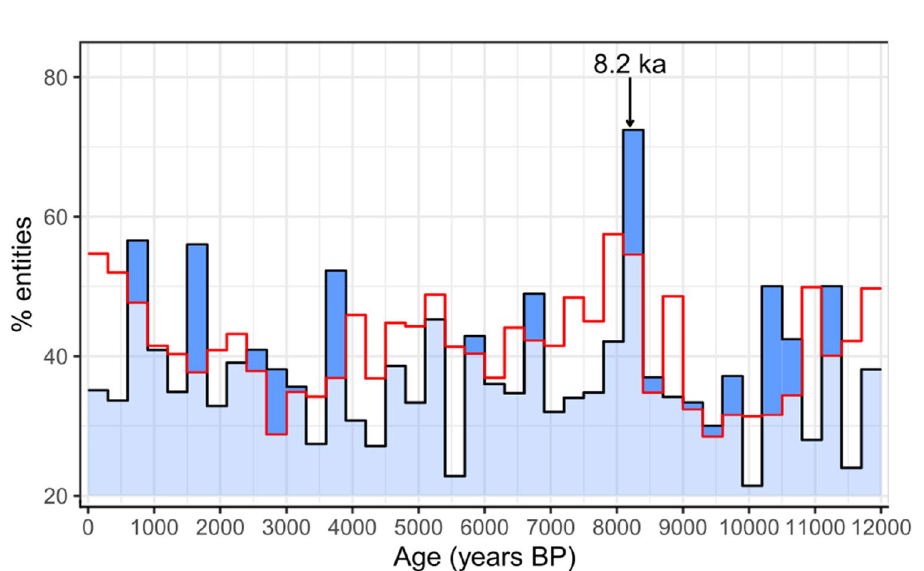
Figure 1. Spatial distribution of speleothem δ 18 O records used in this study. Purple dots show sites that were only used to detect globally significant abrupt events through the Holocene, and green triangles show those used both in the Holocene analysis and to examine the 8.2 ka event. Carbonate bedrock distribution is from the WOrld Karst Aquifer Mapping (WOKAM) project 67 .